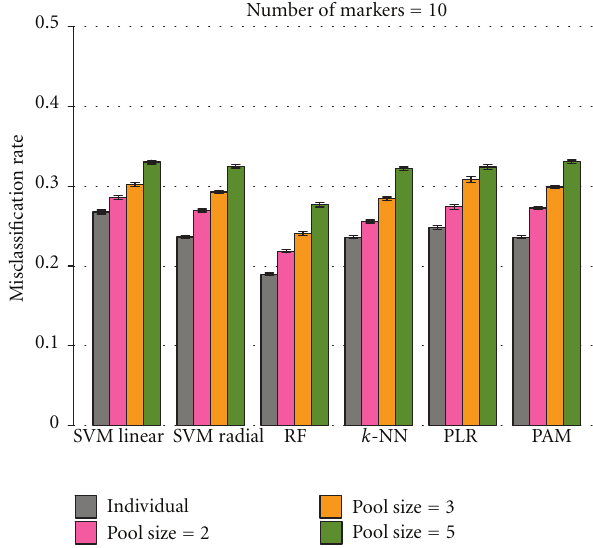
Figure 5: Performance of classifiers based on the animal scenario (sample size = 180). Performance of classifiers for datasets of individual samples and pool sizes of 2, 3, and 5 are compared when numbers of markers = 10 and sample size = 90 samples per class as performed in human scenario. The height of bars indicates 95% confidence interval from 300